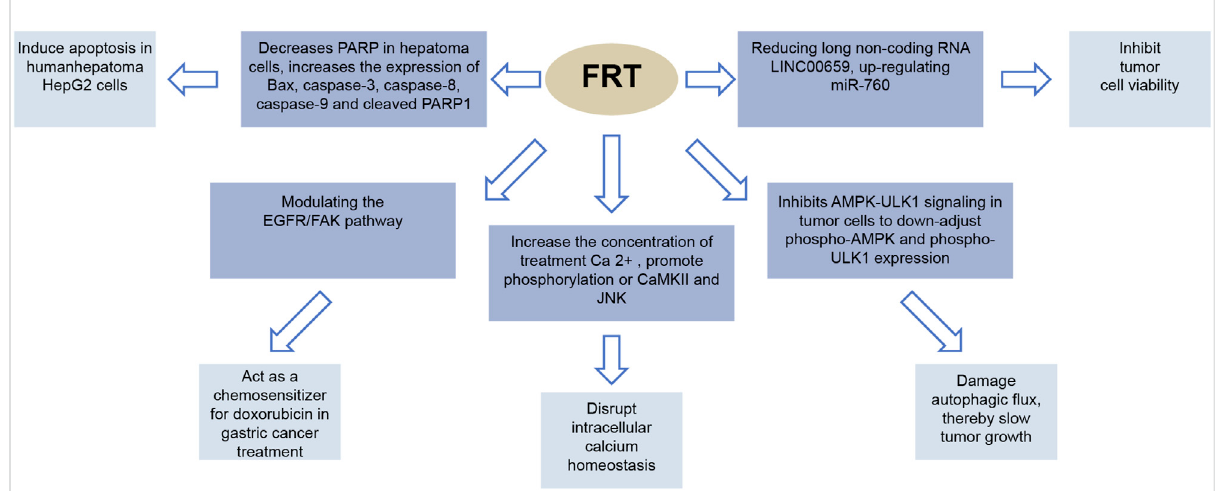
FIGURE 6 Anticancer effect of FRT. PARP (poly-ADP ribose polymerase) is a DNA repair leaven. It plays an important role in DNA damage repair and apoptosis. Baxisapro-apoptotic proteinmemberoftheBcl-2family.EGFRisamemberoftheepidermalgrowth promoterreceptor(HER) clan.FAK (focal adherent kinase)isatyrosine kinase thatis alocaladhesion spot kinase. CaMKII isacalcium/calmodulin-dependent proteinkinase II.JNK,also known as stress-activated protein kinase, plays an important role in a variety of physiological and pathological processes, including cell cycle, reproduction, apoptosis, and cellular